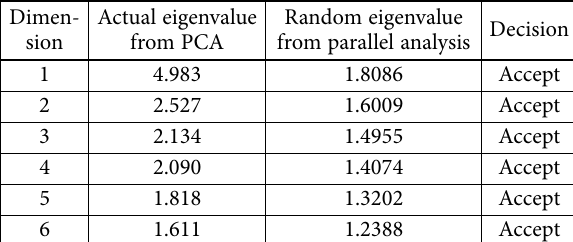
Table 6. Comparison of PCA